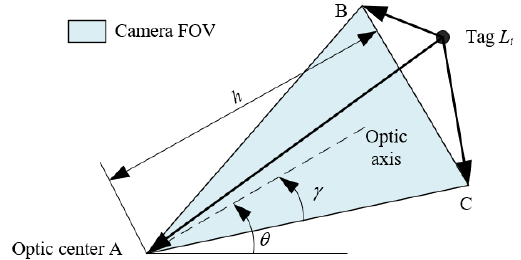
Figure 5. FOV model of camera.